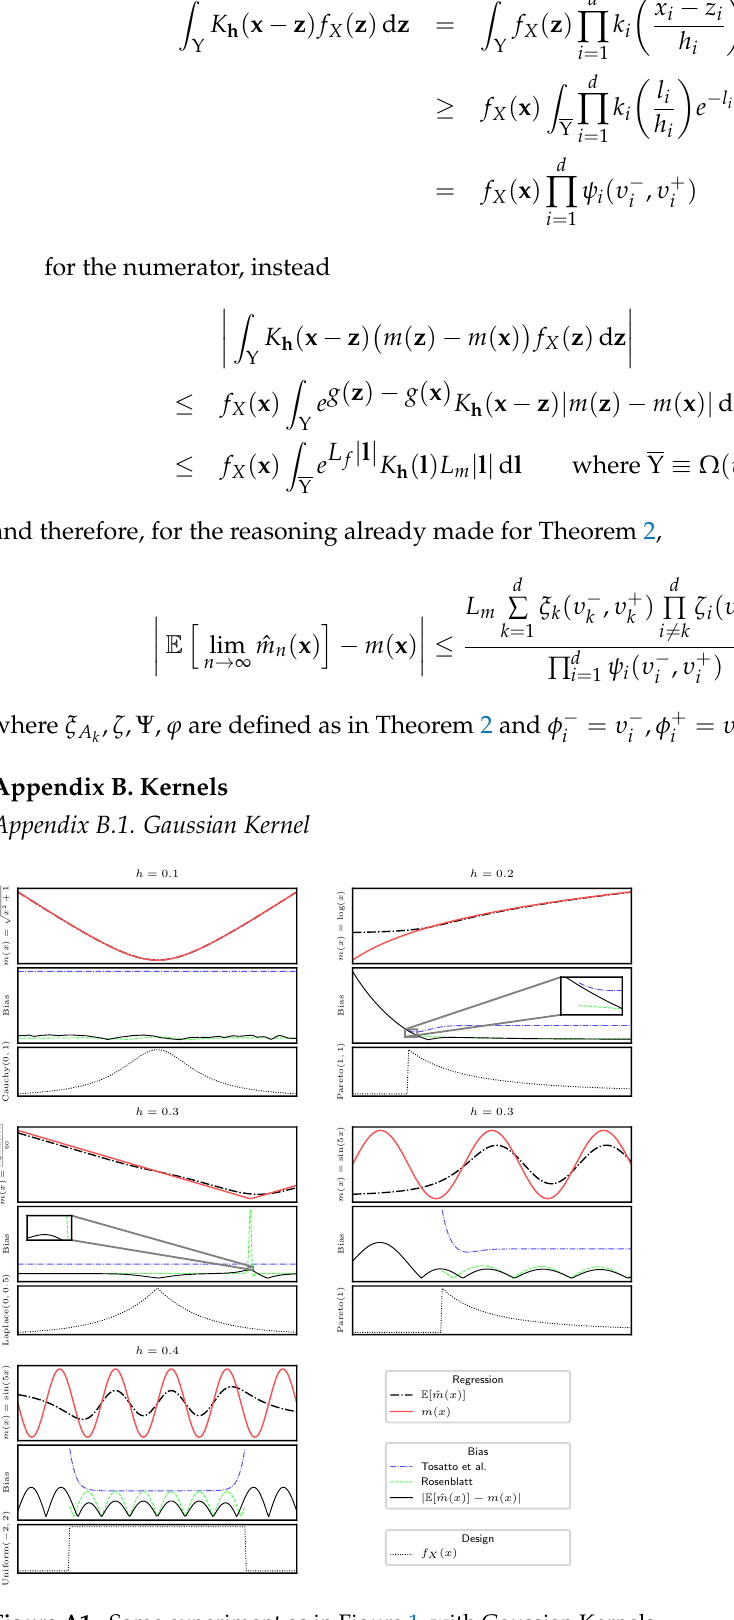
Figure A1. Same experiment as in Figure 1, with Gaussian